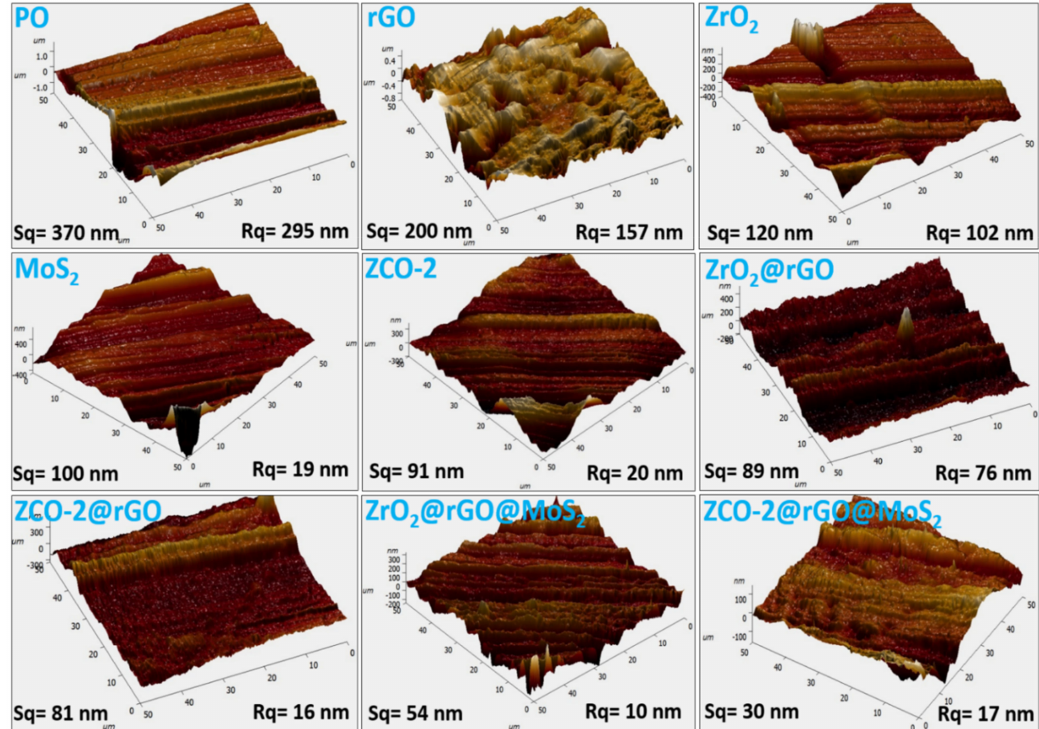
Figure 11. The 3-D atomic force microscopy (AFM) images of the worn steel surface lubricated with blank para ffi n oil (PO) and blends of PO with 0.125% w / v nano additives at 392 N applied